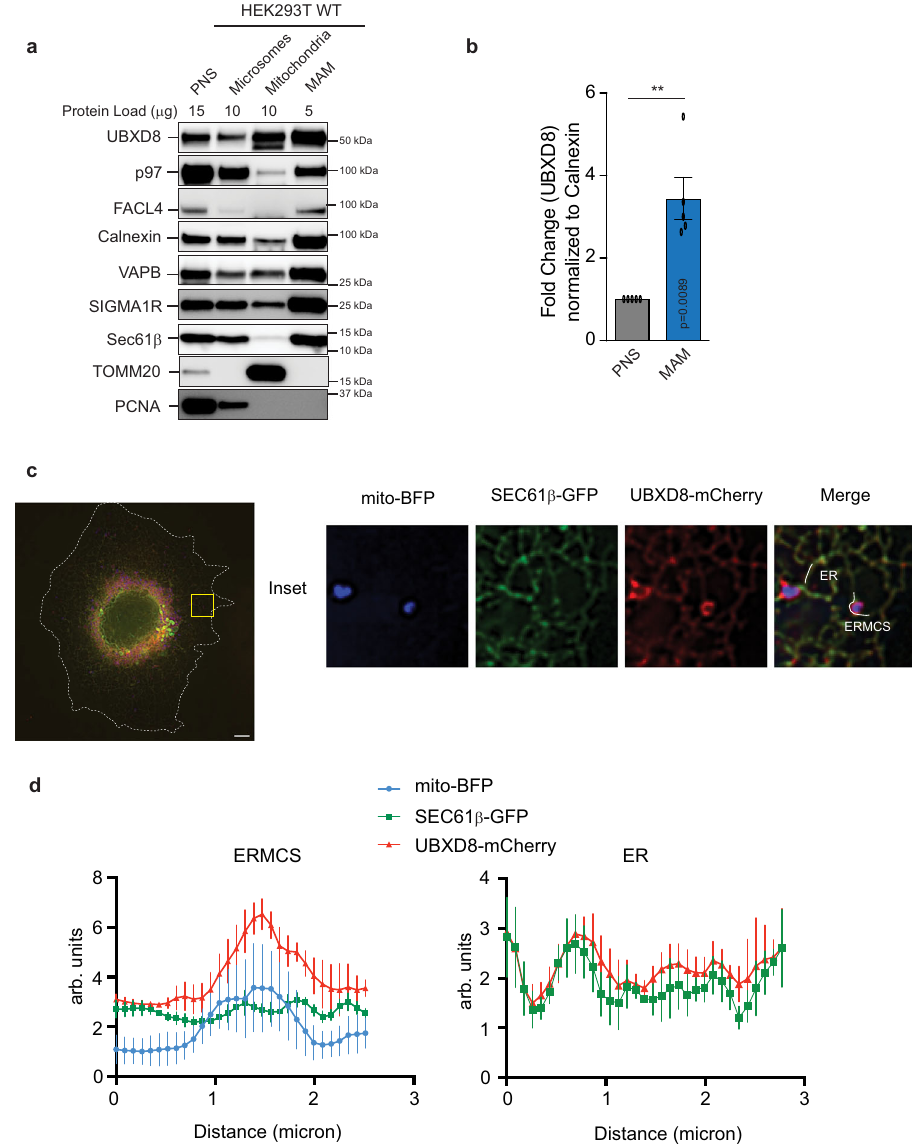
Fig.1|UBXD8isenrichedatERMCS.a Immunoblotoftheindicatedproteinsfrom subcellular fractionation of HEK293T cells. PNS post-nuclear supernatant, MAM mitochondria-associated membrane ( n >3 biologically independent samples). b Quanti fi cation plot showing the enrichment of UBXD8 in MAMs from a as nor- malized to calnexin. ( n =5 biologically independent samples). Data are means± SEM (** P <0.01, two-tailed paired t test). c Confocal microscopy showing